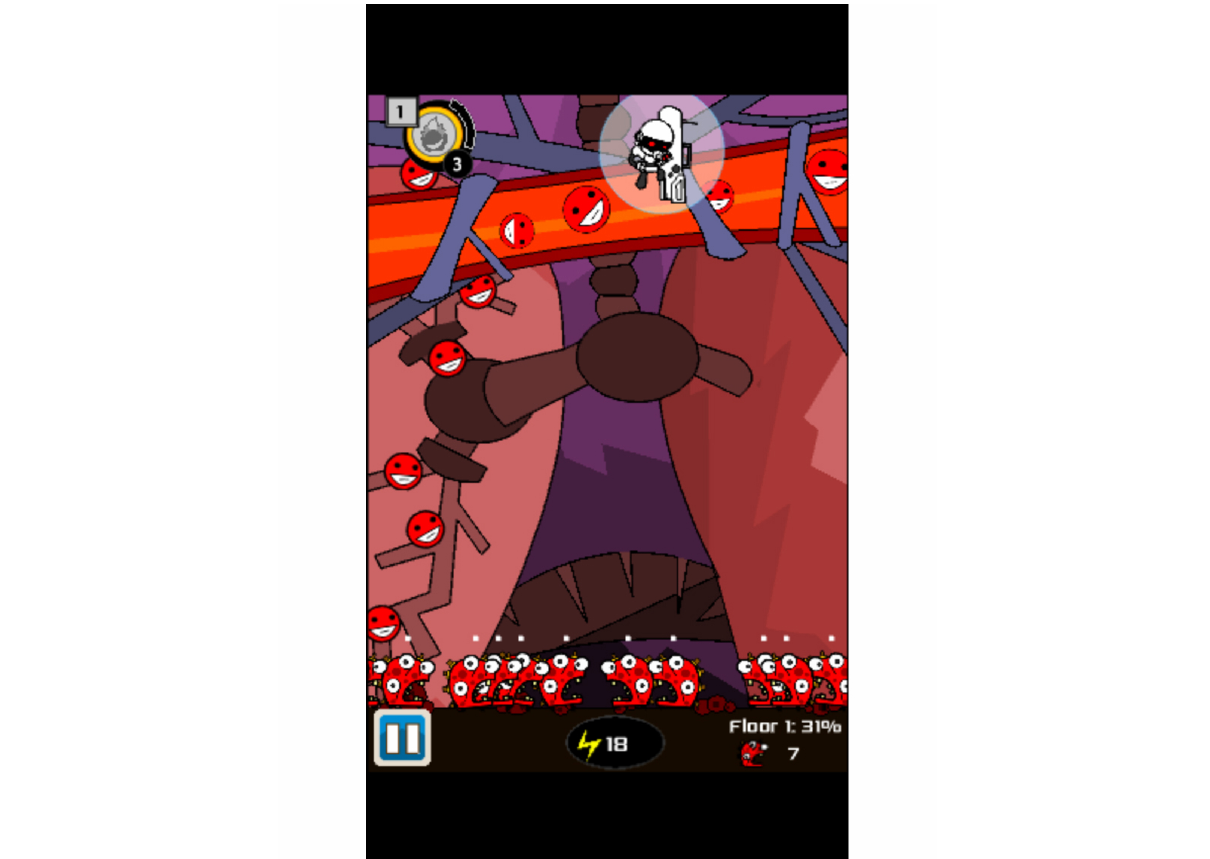
Figure 8. Re-Mission 2: Nanobot's Revenge